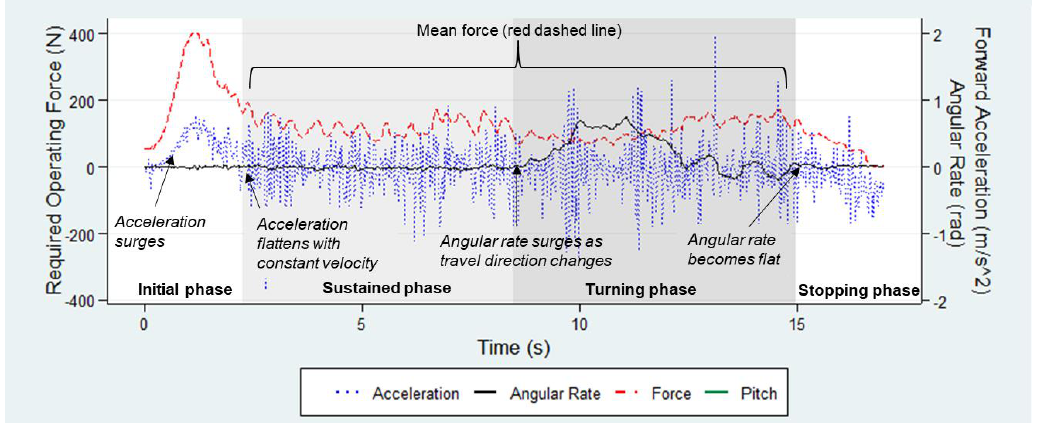
Figure 3. Sample trial with the L-shaped track.